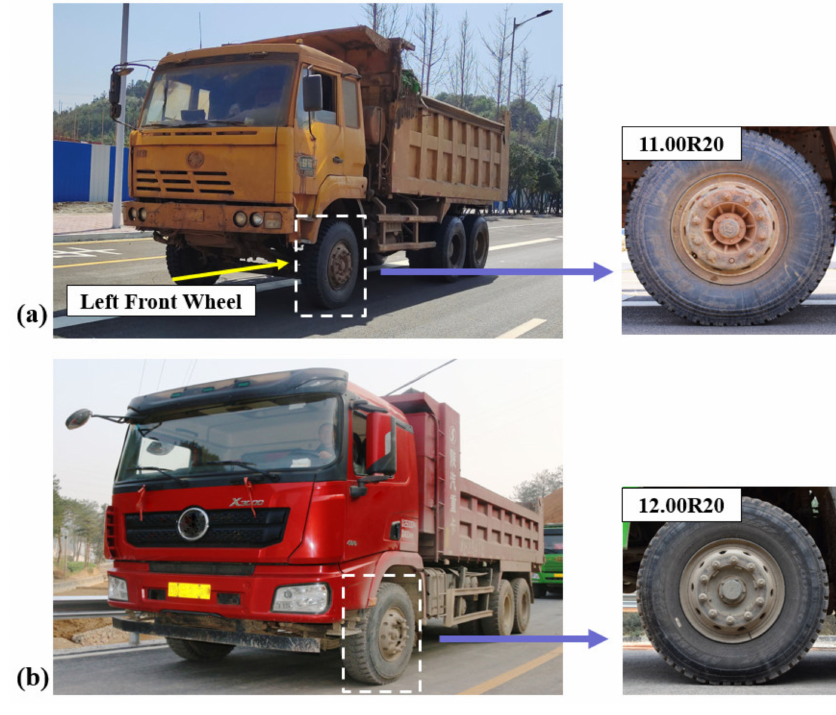
Figure 19. Tested trucks and tires: ( a ) 11.00R20 tires; ( b ) 12.00R20 tires.